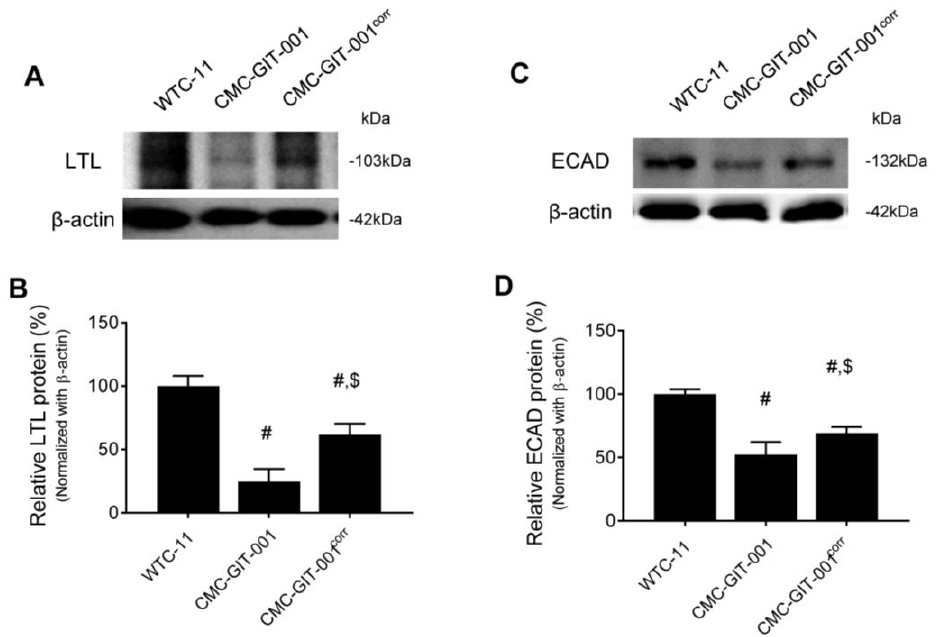
Figure 5. Expression of LTL and ECAD in kidney organoids from CMC-GIT-001 and CMC-GIT- 001 corr iPSCs. Representative immunoblot image and LTL ( A , B ) and ECAD ( C , D ) quantification in the kidney organoids from WTC-11 as a control, CMC-GIT-001, and CMC-GIT-001 corr . The relative optical densities of the bands in each lane were normalized to those of each band of β -actin. Data are presented as mean ± SE. # p < 0.05 vs. WTC-11; $ p < 0.05 vs. CMC-GIT-001.